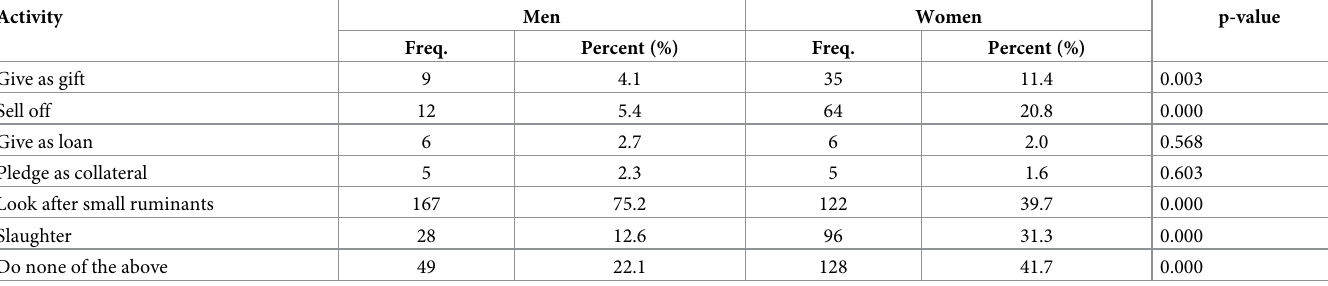
Table 3. Activities carried out by men and women on jointly owned small ruminants without consultation. Activity